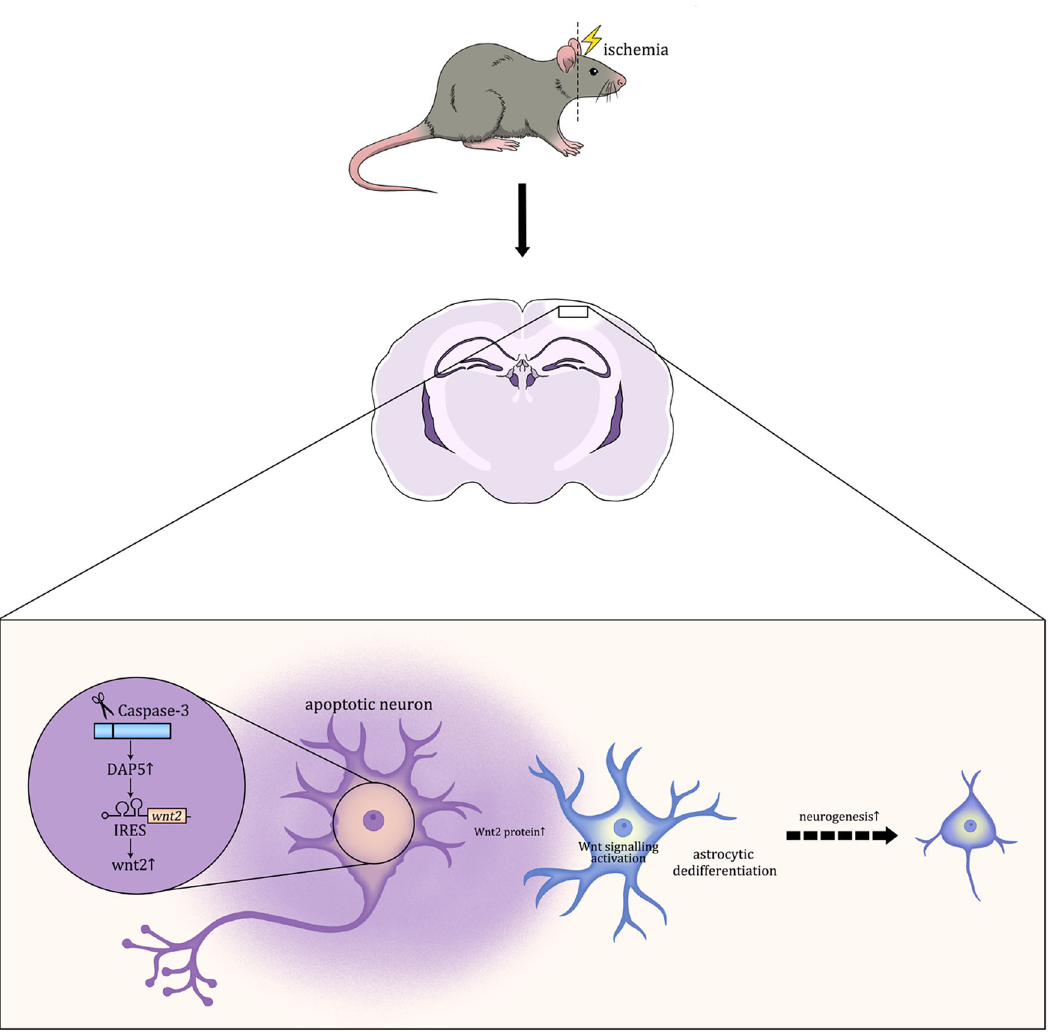
Fig. 11 Schematic graph of the major fi nding. Following cerebral ischemia, apoptotic neurons up-regulate Wnt2 protein via IRES mediated protein translation. Released Wnt2 activates Wnt/ β -catenin signaling in reactive astrocyte and triggers astrocytic dedifferentiation, which facilitated cortical